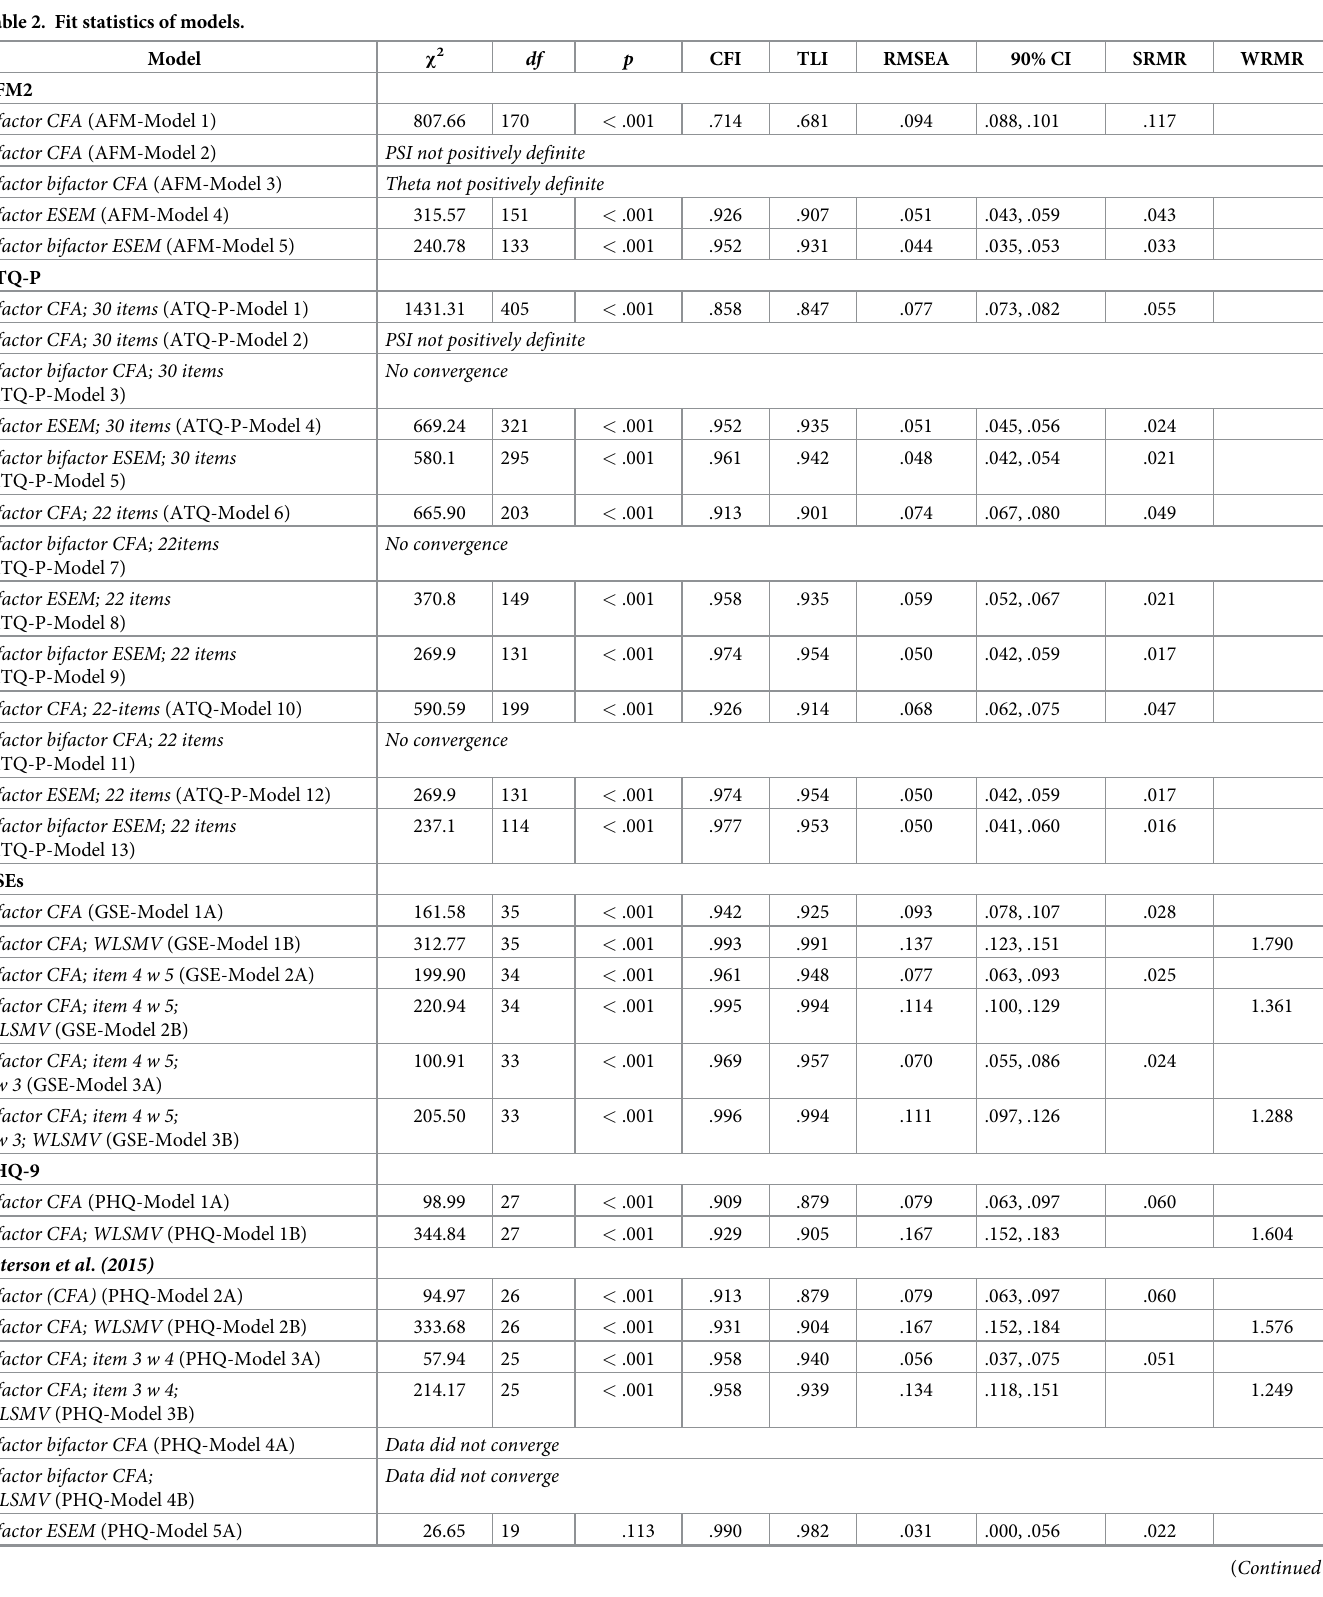
Table 2. Fit statistics of models.